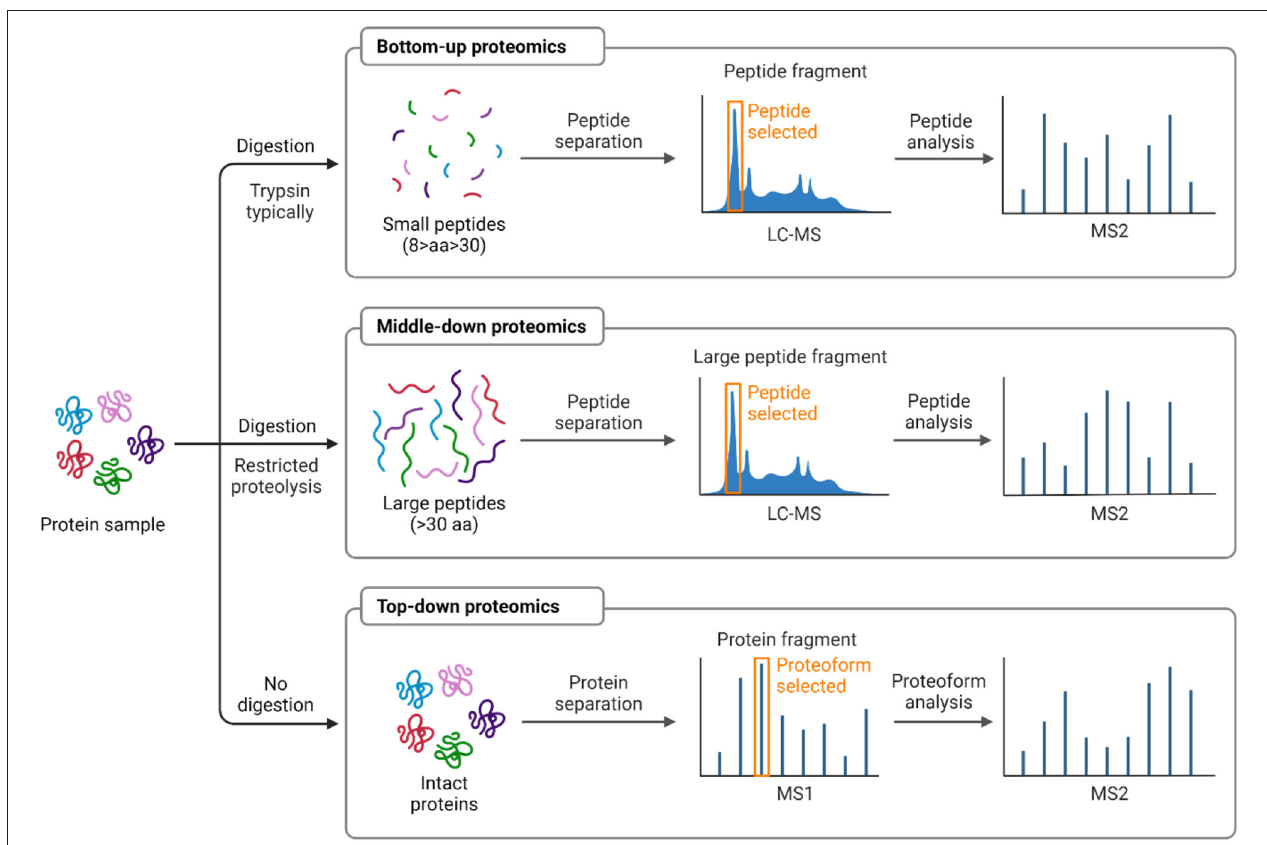
FIGURE 2 | Schematic representing proteomic-based strategies: bottom-up vs. top-down vs. middle-down. In bottom-up approach, a protein is typically digested with an enzyme (i.e., trypsin) into many small peptides either in gel or in solution. The recovered peptides will be detected by mass spectrometer and a specific peptide can be isolated and fragmented by MS/MS to identify the protein from the database. Whereas in top-down method, the whole protein is analyzed directly in the mass spectrometer without digestion. The middle-down strategy analyzes larger peptides resulting from limited digestion or more selective proteases. One or more protein or peptide fractionation techniques can be applied prior to MS analysis and database searching. Modified and adapted from ( 16, 51). Schematic created with